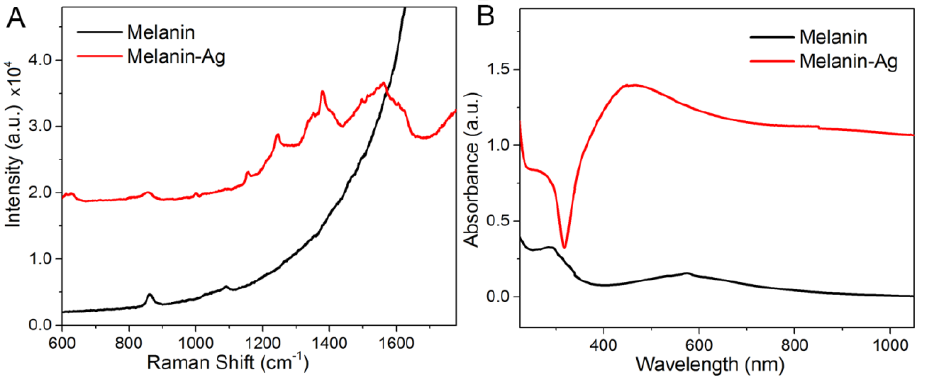
Figure 2. ( A ) Raman spectra under 514.5 nm excitation and ( B ) the UV-Vis absorbance spectra of the nanomaterials.